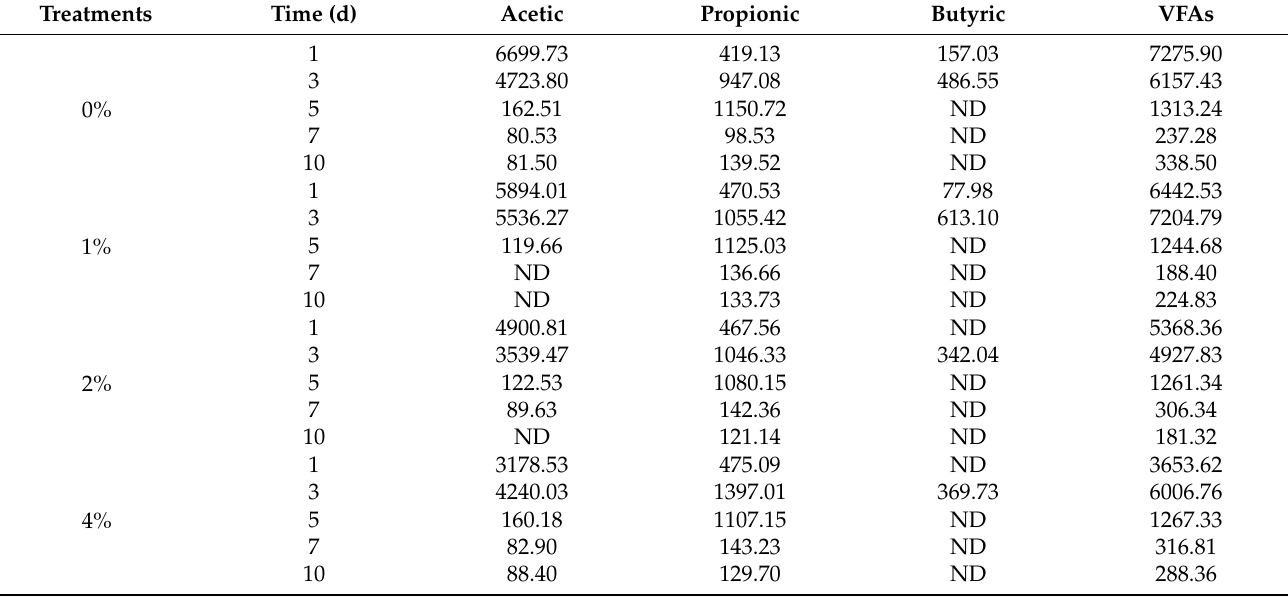
Table 3. Volatile fatty acid (VFA) concentration in different treatments during anaerobic digestion (AD).